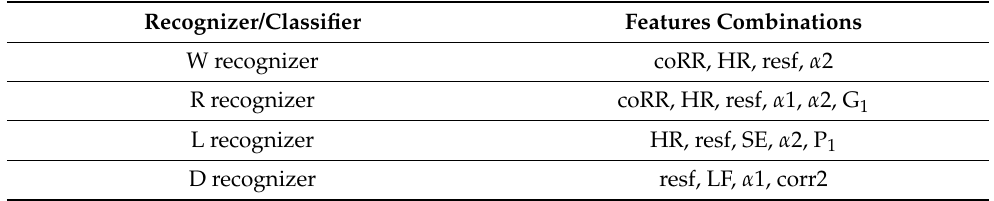
Table 4. Feature combinations that suit each recognizer best.